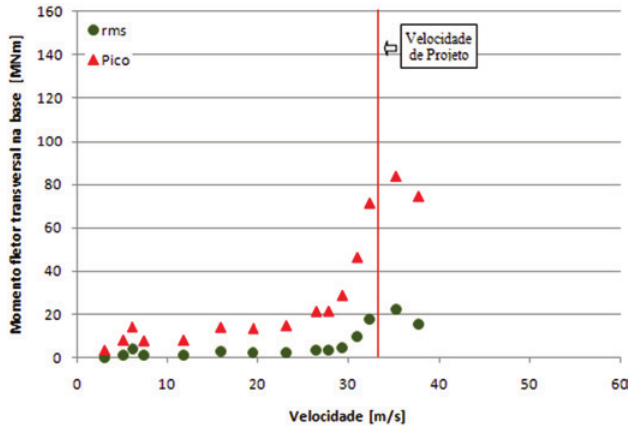
Transverse bending moment at the base of the chimney as a function of the wind speed at the top of the structure. Configuration with neighborhood. Angle of wind incidence: